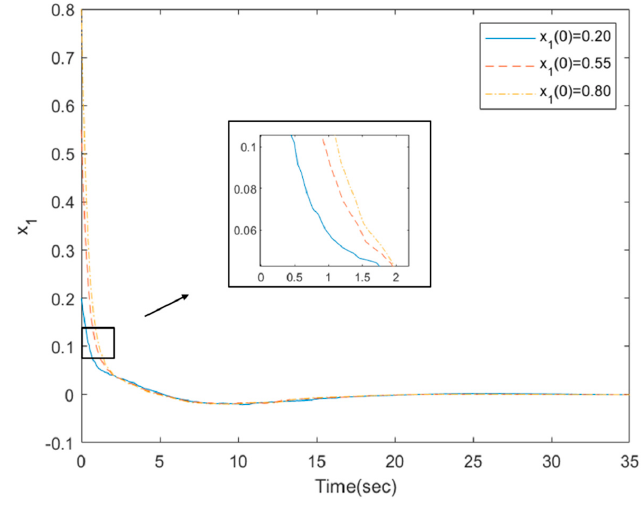
Figure 2. Response of x 1 ( t ) .